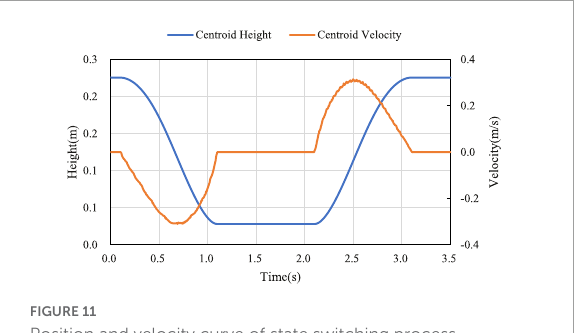
FIGURE11 Position and velocity curve of state switching